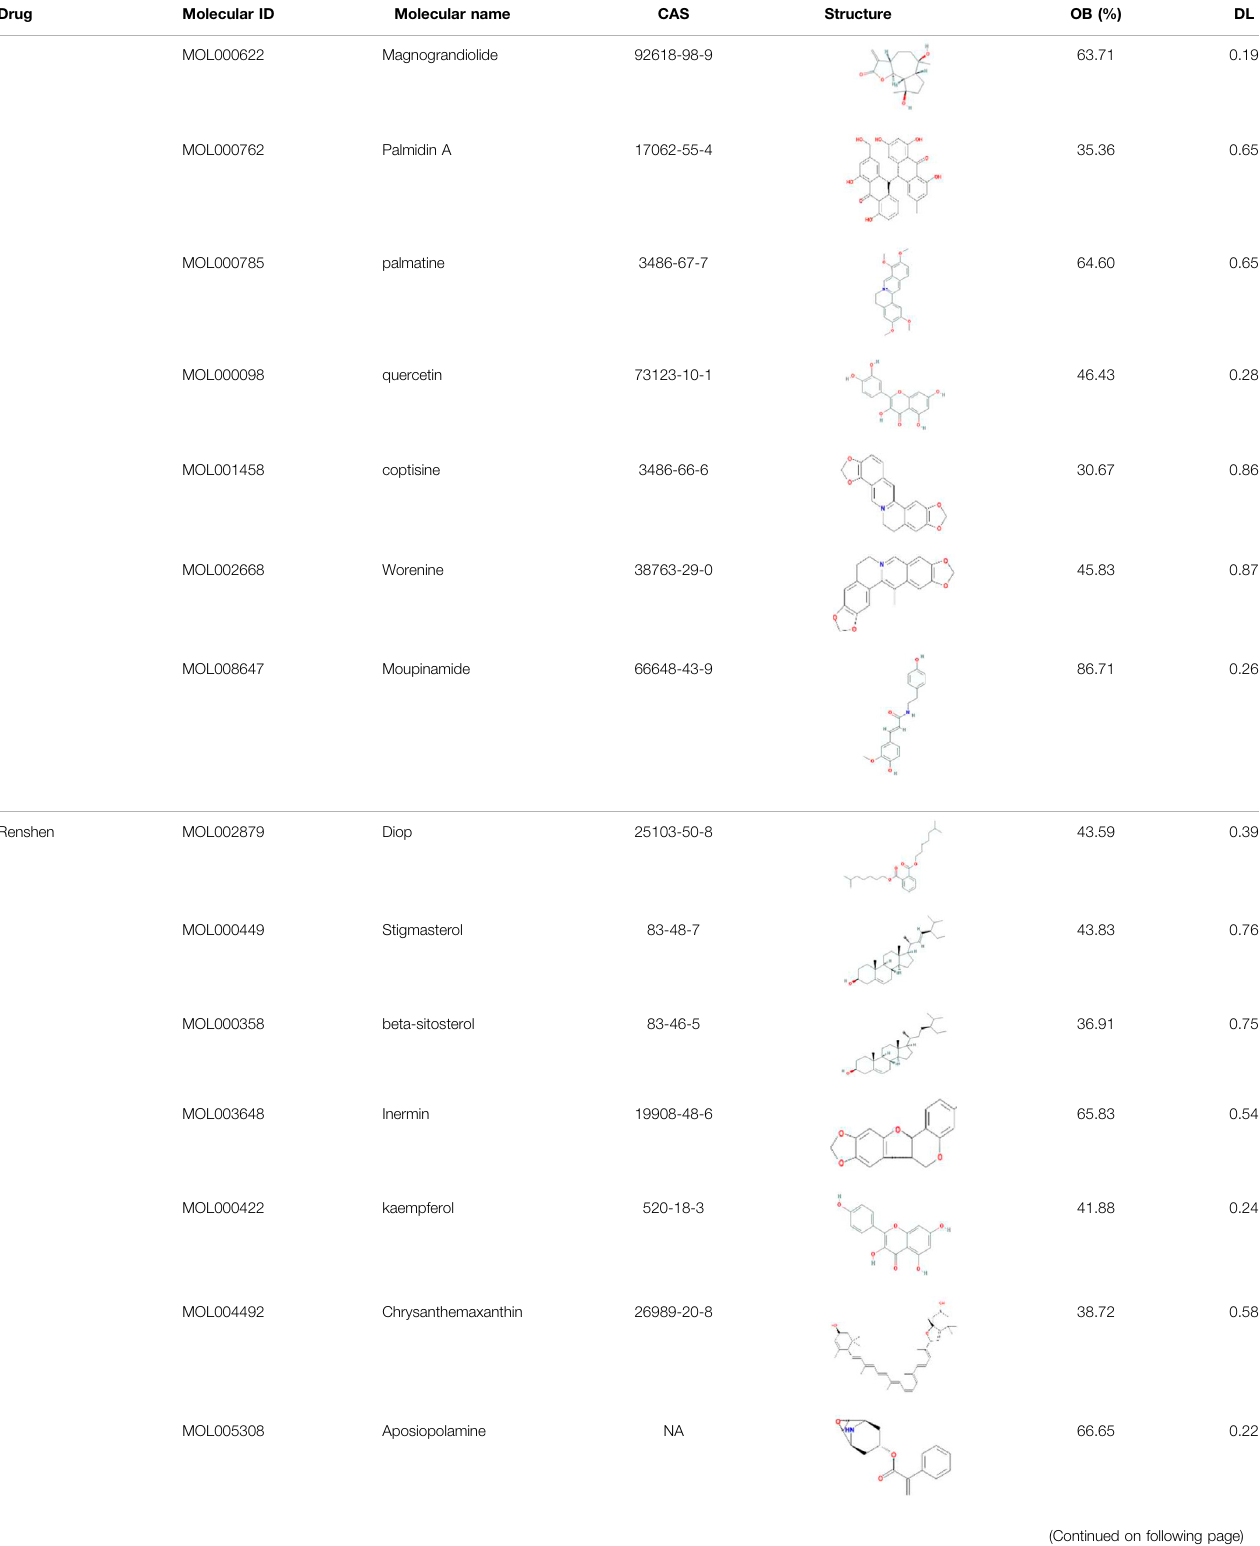
TABLE 1 | ( Continued ) The fi nal selected ingredients in YZQX for